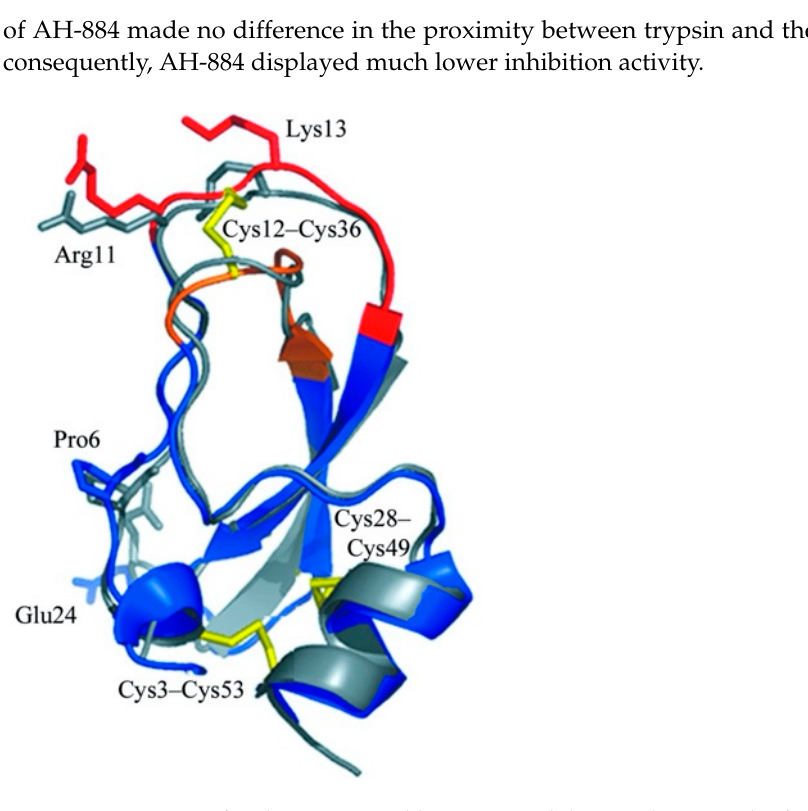
Figure 4. Structure of a classic Kunitz-like trypsin inhibitor, rShPI-1A. The figure was adjusted from the RCSB protein data bank [28], CC BY 4.0 license. PDB ID: 3OFW. The disulfide bonds were represented in yellow, and the binding loops were marked in red and brown.